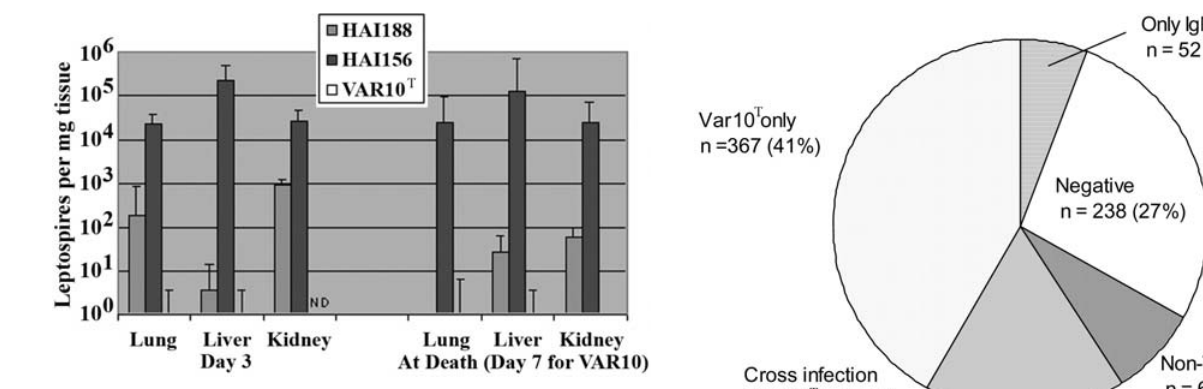
Table 3. ‘‘Leptospira licerasiae’’ serovar Varillal Seroreactivity in Acute Leptospirosis Patients from Different Regions of Peru.